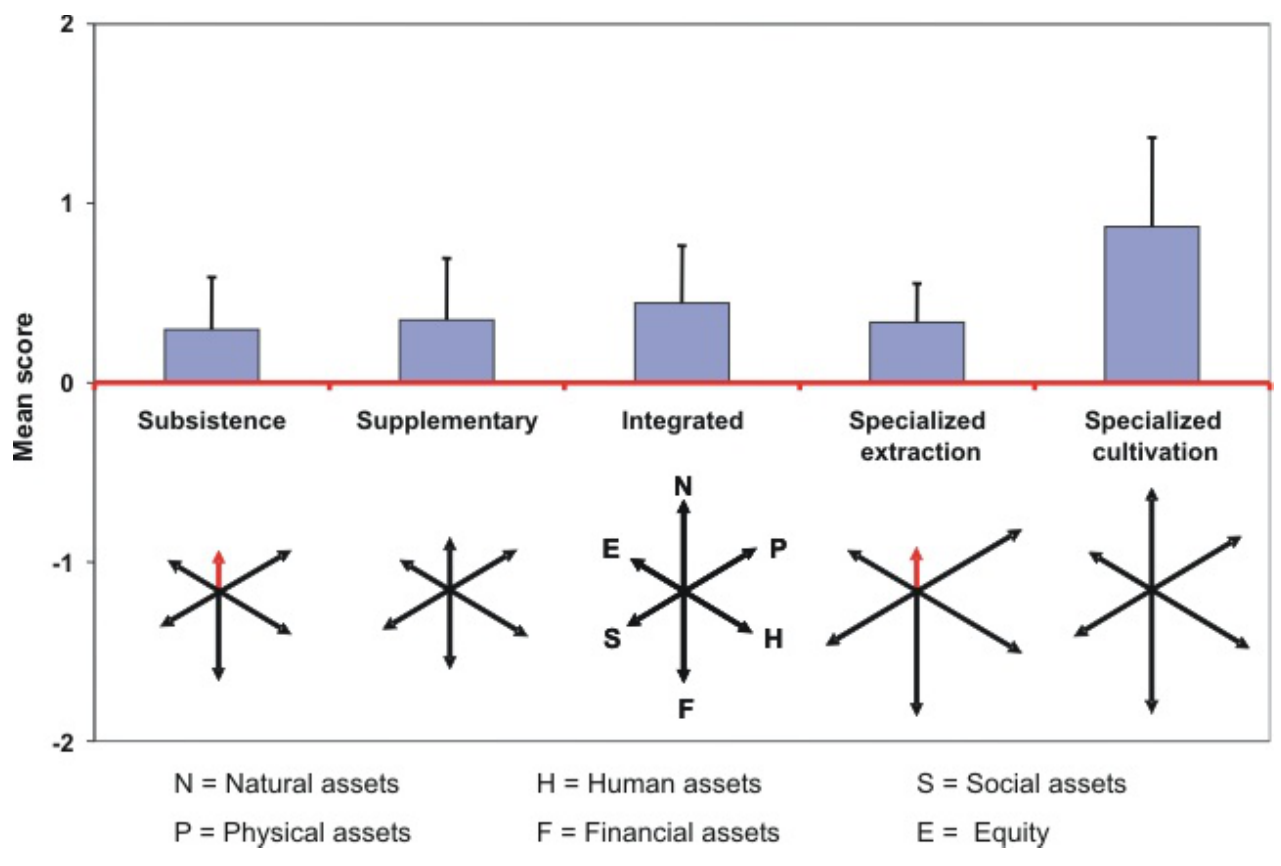
Fig. 2. Aggregated mean livelihood outcomes of different household strategies. The bars represent the mean and the lines represent the standard deviation. The star diagrams in the lower half of the figure present the relative contributions of different livelihood components to the aggregated mean. A red arrow indicates a negative